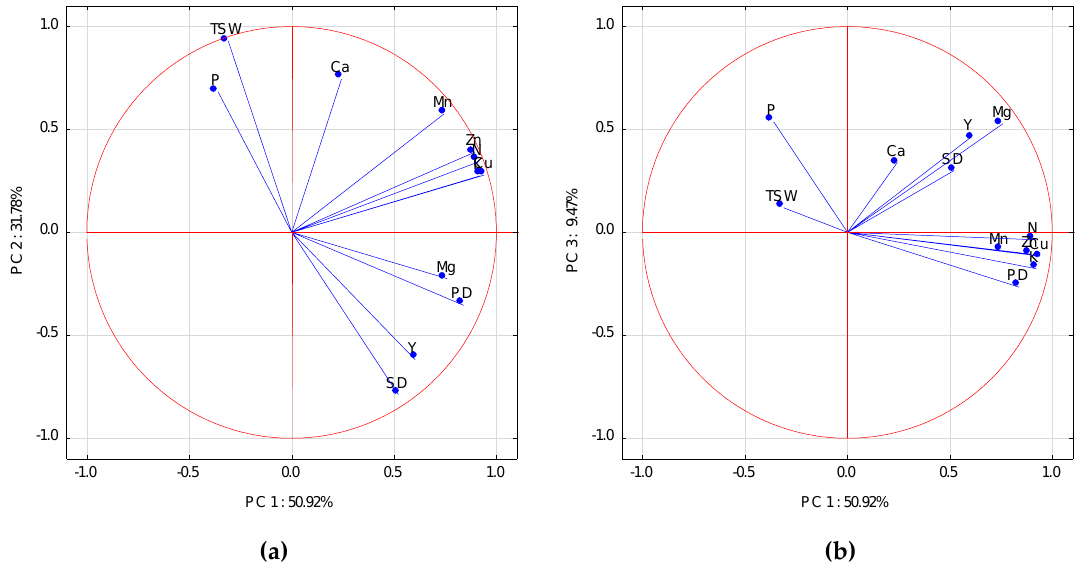
Figure 1. ( a ) Score plot of winter oilseed rape (WOSR) components and nutrient accumulated in WOSR biomass at flowering in PC1 and PC2 axes. ( b ) Score plot of WOSR components and nutrient accumulated in WOSR biomass at flowering in PC1 and PC3 axes. Y — Yield, SD — Seed Density, PD — Pod Density, TSW — Thousand Seed Weight, N, P, K, Mg, Ca, Mn, Zn, Cu — nutrients.